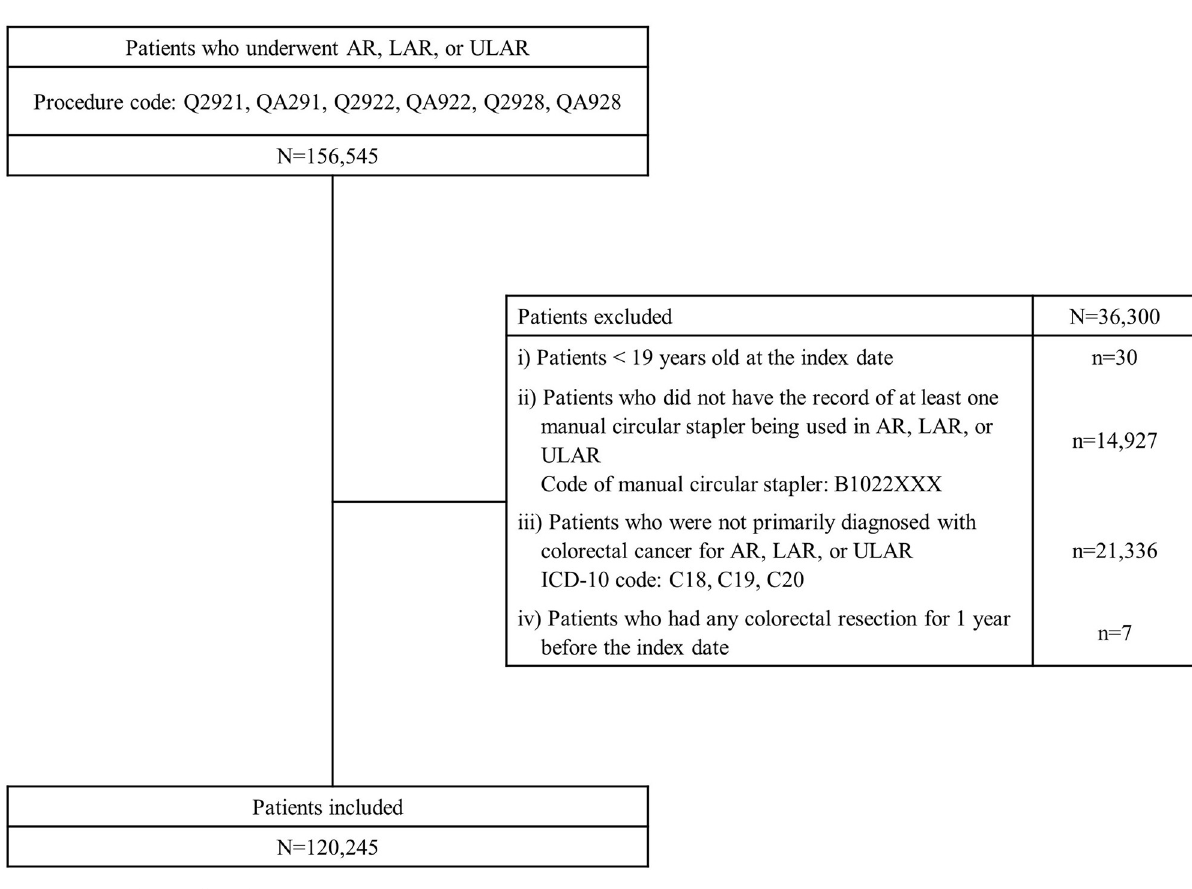
Fig 1. Pateint selection flow